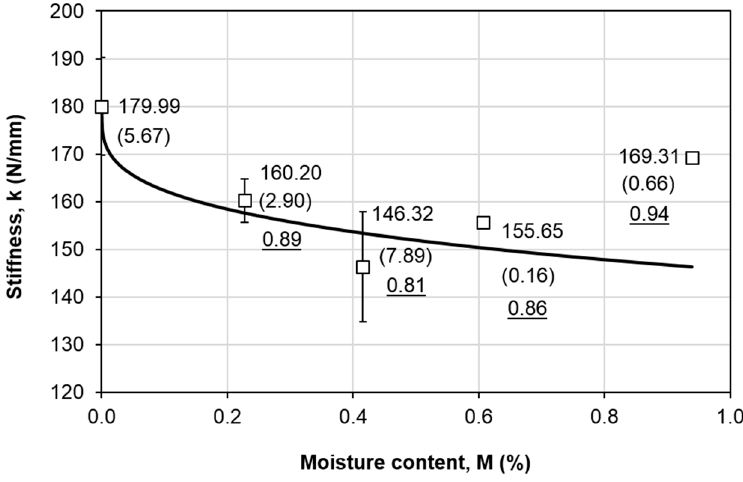
Figure 6. Variation of the stiffness with respect to the moisture content level.